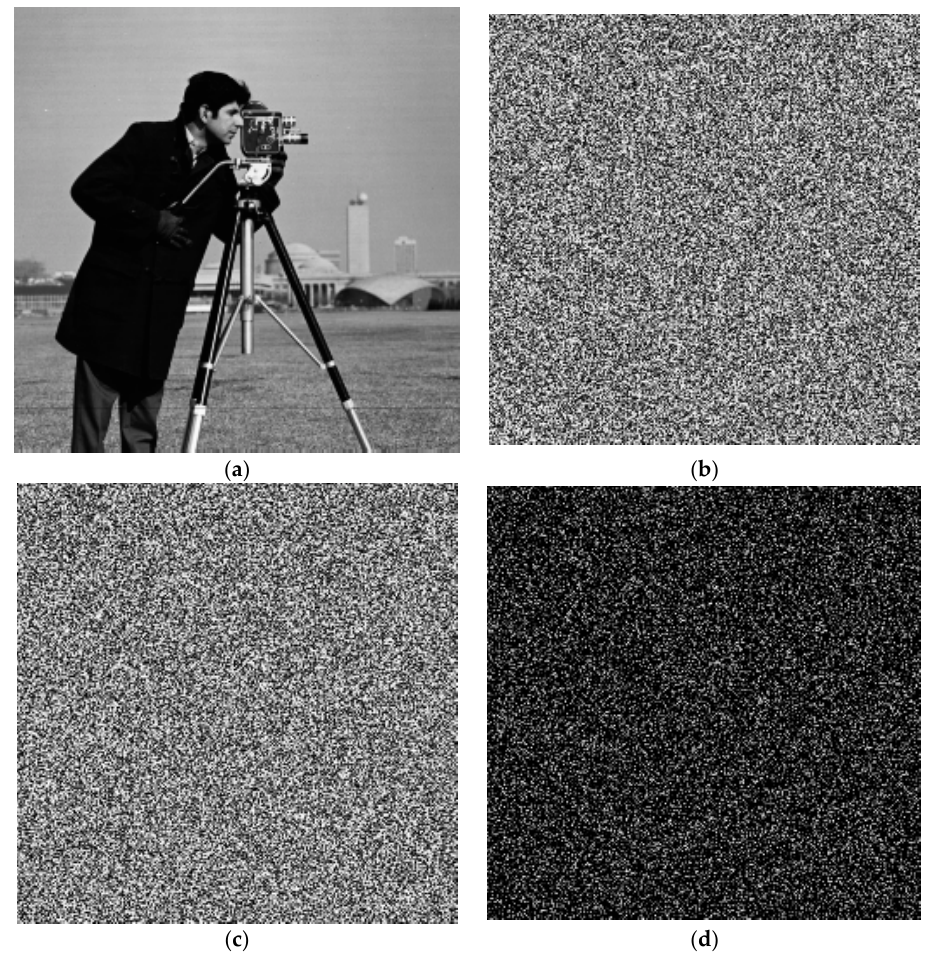
Figure 3. Key sensitivity for Cameraman. ( a ) Plain-image of Cameraman; ( b ) Encrypted image by key: 123456789012345; ( c ) Encrypted image by key: 123456789012346; ( d ) Difference image.